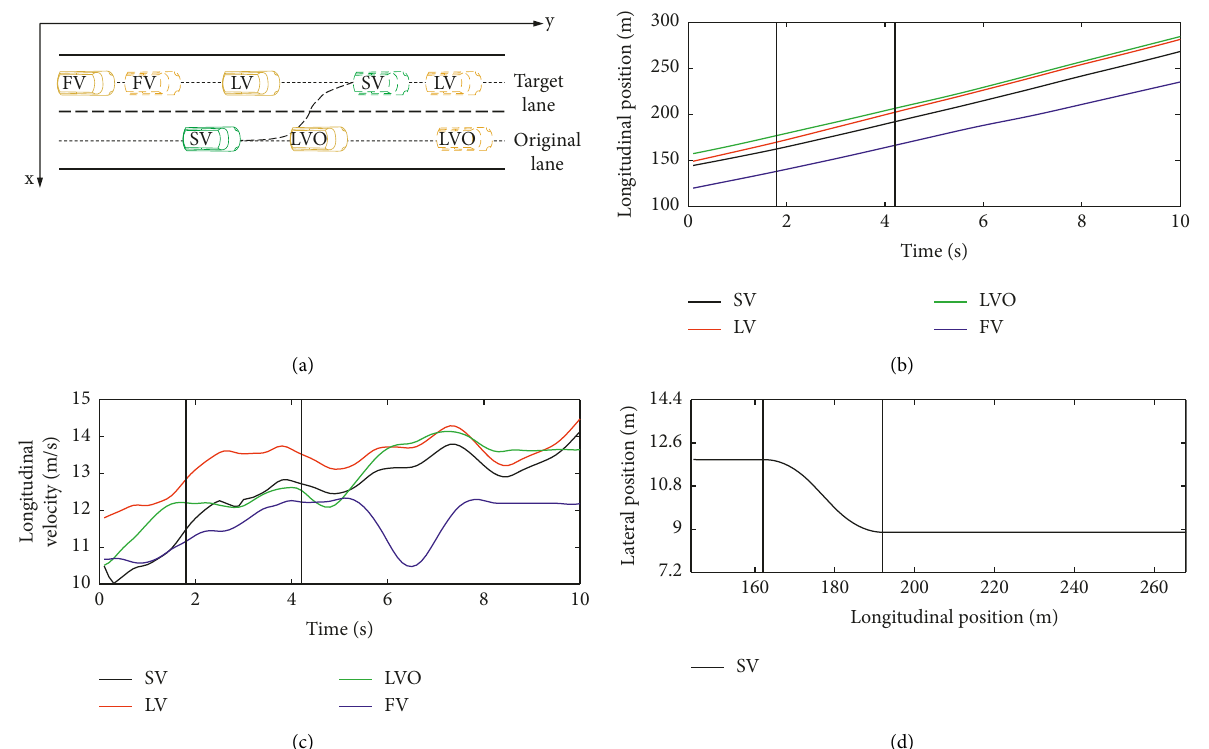
Figure 11: #1 sampled lane-changing scenario. (a) Initial and final state. (b) Plot of longitudinal position with respect to time. (c) Plot of longitudinal velocity with respect to time. (d) Lane-changing